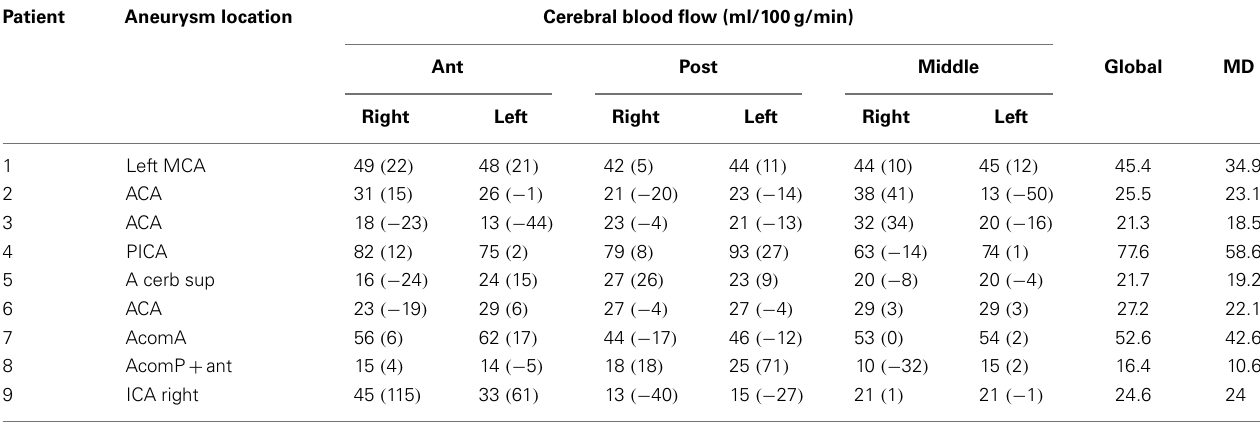
The changes in CBF between right and left side in different vascular regions compared to global CBF are presented in bracket (%). R, right; L, left; MCA, middle cerebral artery;AcoA, anterior communicating artery; PcoA, posterior communicating artery; SCA, superior cerebellar artery; PICA, posterior inferior cerebellar artery; MD, microdialysis